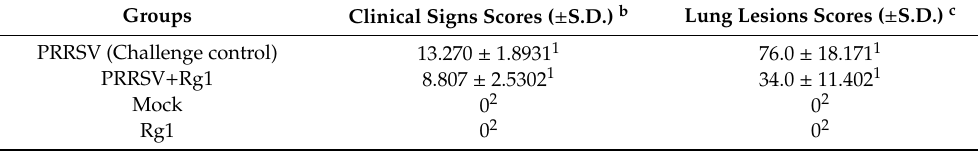
Table 3. The scores of clinical signs and lung lesions of the di ff erent groups at 7 d.p.i. a .